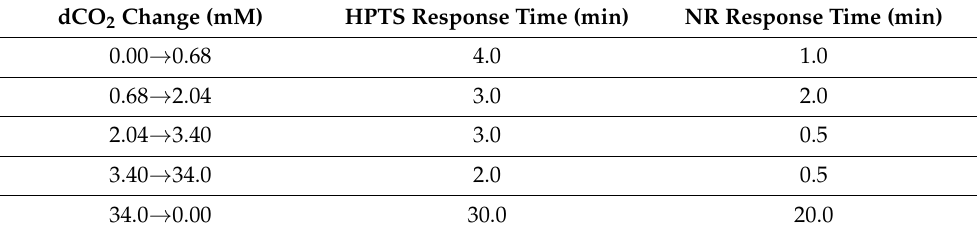
0 → 34.00 Table 3. Response times for 3.1 × 10 − 5 M HPTS and 3.1 × 10 − 5 M NR in phosphate buffer at pH 7.0. dCO 2 Change